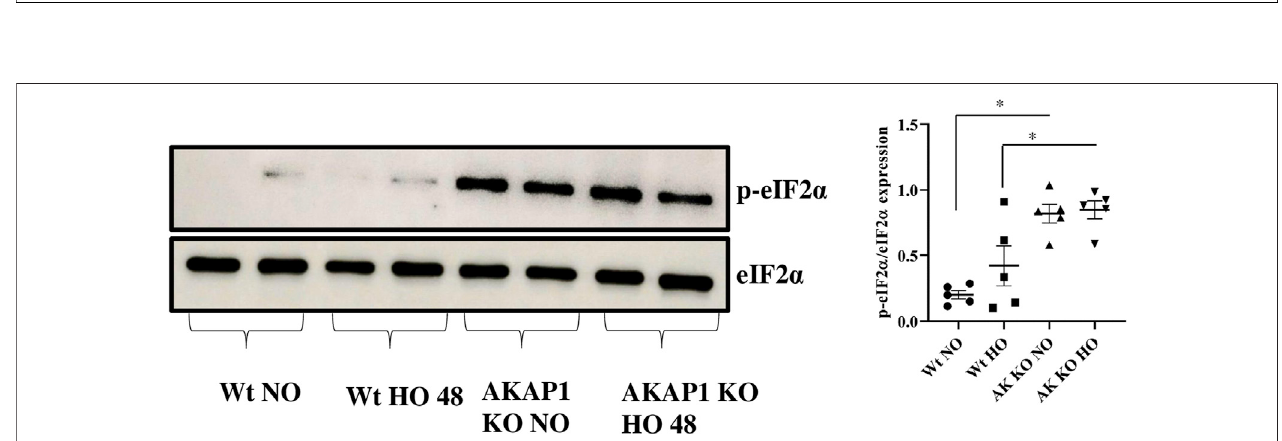
FIGURE4 | Akap1 genetic deletion causes phosphorylation ofeukaryoticinitiation factor (eIF2 α ): Wt and Akap1 mice were exposed to normoxia and hyperoxia for 48 h. After hyperoxia, the mice were killed, and protein was extracted from the lungs and subjected to Western blot analysis. Following densitometry analysis and normalization with β -actin, the ratio of p -eIF2 α to eIF2 α protein levels was evaluated. Results are expressed in fold change. Data are shown as mean ± SEM (* p < 0.05) ( n = 5 mice per group). NO, normoxia; HO, hyperoxia; AK, Akap1 ; KO: Knockout.